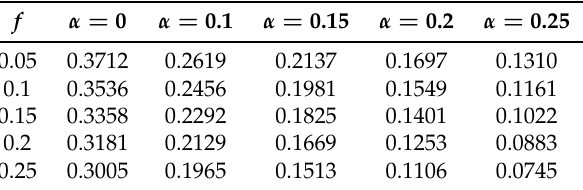
Table 7. Maximum allowable upper bounds b of Example 1.